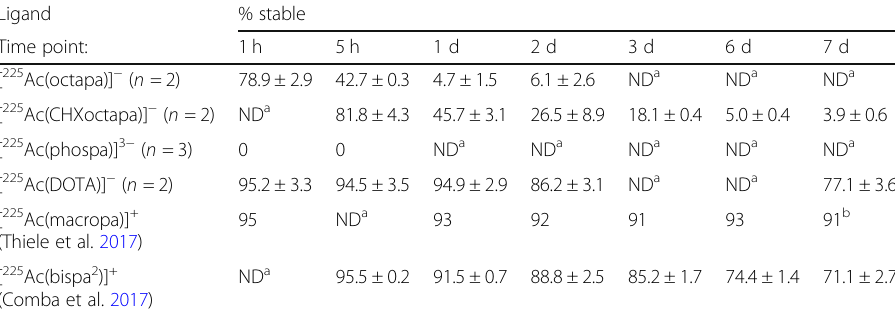
Table 4 Stability of 225 Ac-Labelled Chelate Complexes in 50-fold excess La III at ambient temperature Ligand % stable Time